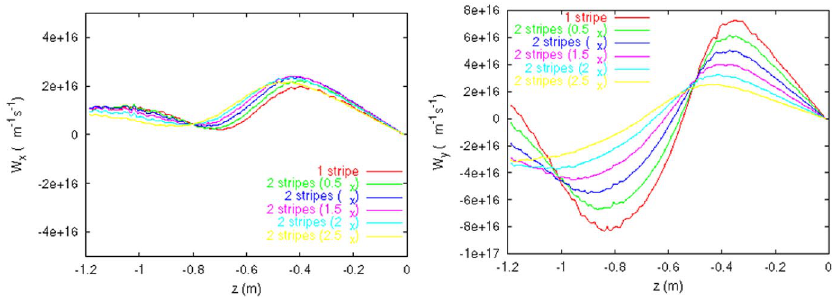
FIG. 73. (Color) Horizontal (left) and vertical (right) averaged dipole wake functions for a Gaussian SPS bunch in a dipole field; the various curves refer to different initial electron distributions (a single 4 (cid:16) increasing distances from the center); the different stripe distributions yield different wakefields for the same average density